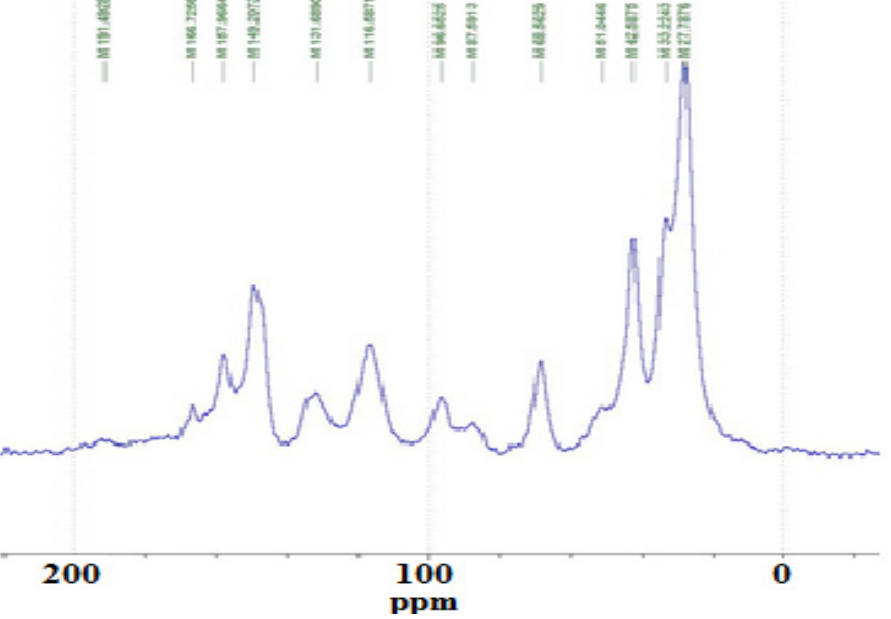
Figure 13. Cross-polarisation/magic-angle spinning (CP-MAS) 13 C NMR spectrum of the reaction of the catechin model compound with hexamethylene diamine at 100°C, NaOH-catalysed.